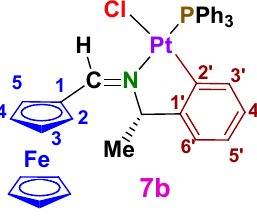
Figure A4. Atom labelling scheme for compound 7b .